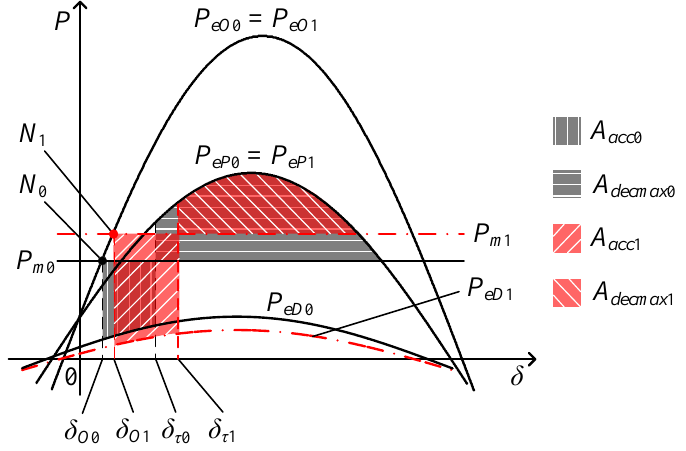
Figure 7. The comparison of the equivalent P -δ curves between the wind case operating in scenario one and the no-wind power case.